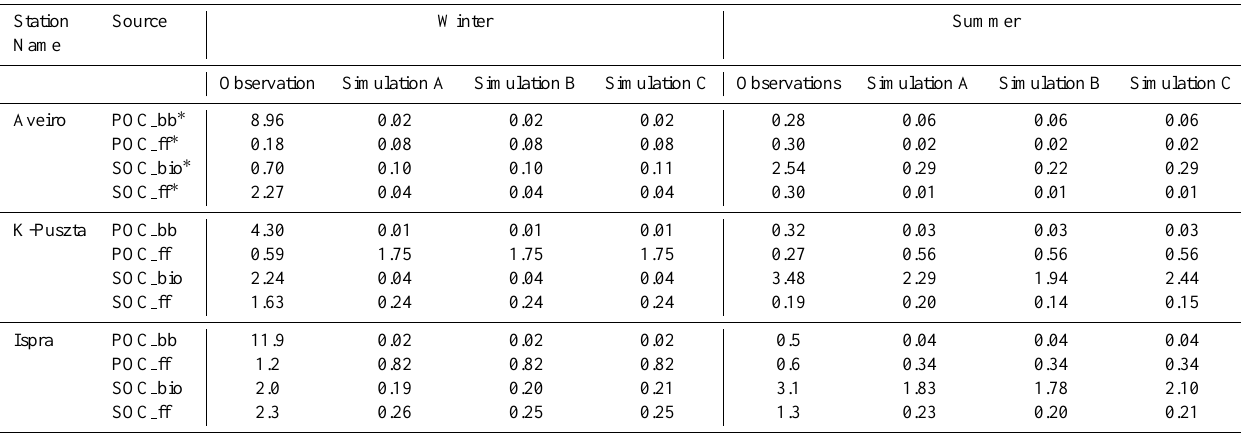
∗ POC bb: primary organic carbon from biomass burning; POC ff: primary organic carbon from fossil fuel and biofuel burning; SOC bio: secondary organic carbon from the oxidation of biogenic species; SOC ff: secondary organic carbon from fossil fuel and biofuel burning. Half of the POC burden is assumed to be composed of low-volatility compounds that may have undergone reactions and partitioned back into the aerosol form as SOA after